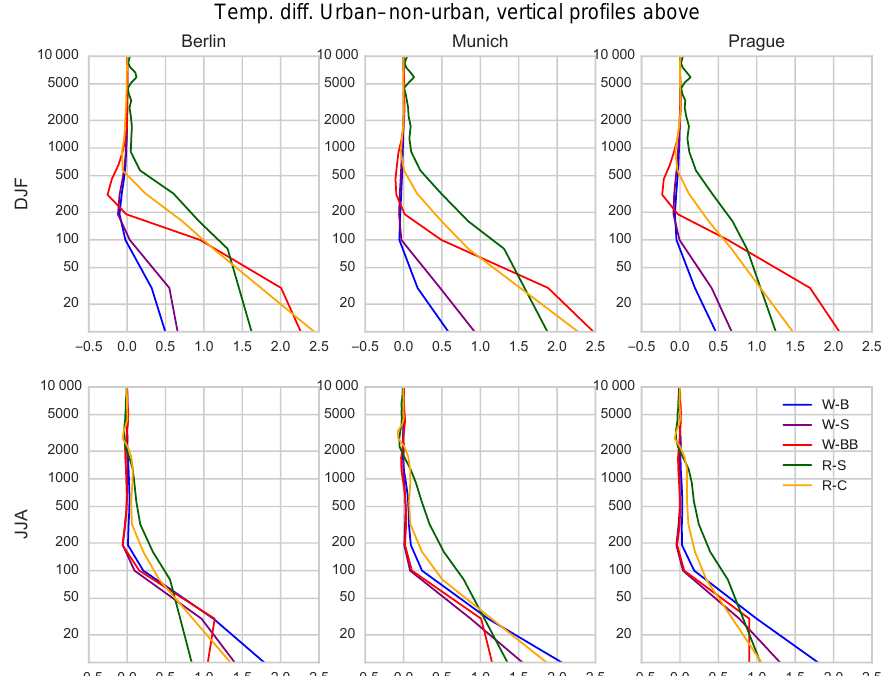
Figure 12. The impact of the urban surface inclusion on the temperature vertical profile (in ◦ C) over selected cities. The y axis indicates the altitude in metres.